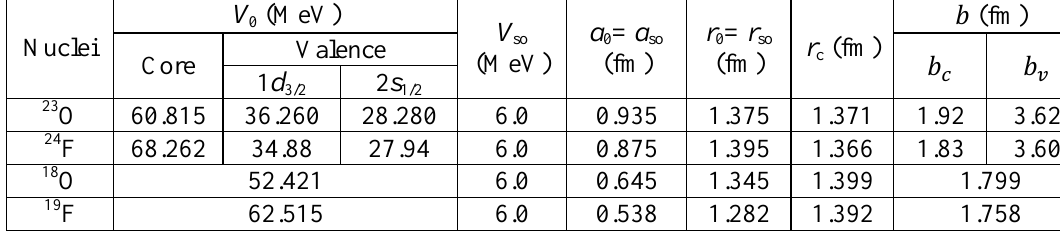
Table 3: Proton and neutron rms radii for the selected nuclei.